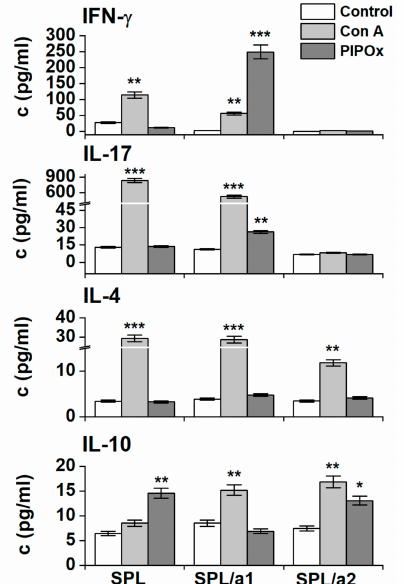
Figure 3. Production of cytokines after in vitro stimulation. Concentrations of IFN- γ , IL-17, IL-4 and IL-10 in media after stimulation of splenocytes and adherent spleen cells after the 1st (SPL/a1) and the 2nd (SPL/a2) adherence period. Response to stimulation with Con A (10 µ g/mL) and PIPOx (5 mg/mL). As a negative control, media of unstimulated cells were used. All data are shown as mean ± SD and statistical significance of differences between Con A or PIPOx-stimulated cells and unstimulated cells are expressed: ***— p < 0.001, **—0.001 < p < 0.01, *—0.01 < p < 0.05. Tests were performed in